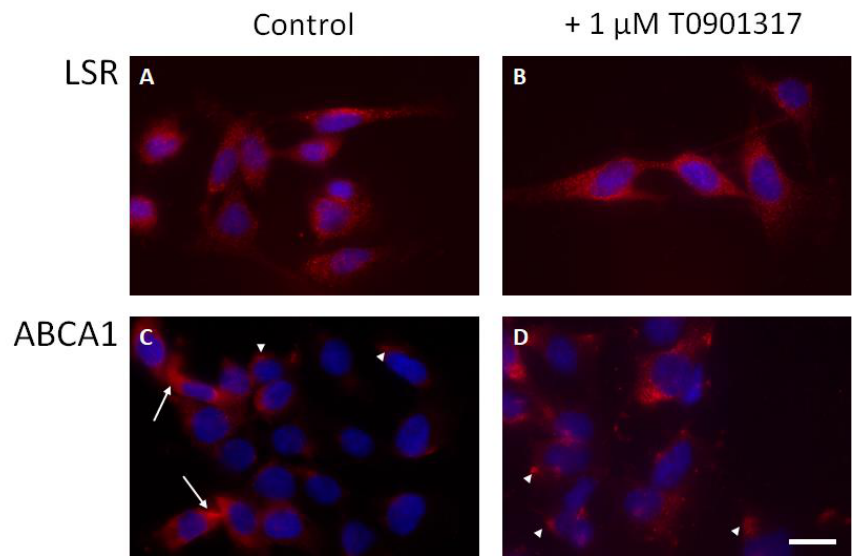
Figure 5. LSR and ABCA1 localization in astrocytes. LSR ( A , B ) and ABCA1 ( C , D ) protein levels were detected by immunofluorescence (red) in astrocytes grown in normal growth media (NM) in absence ( A , C ) or presence ( B , D ) of LXR agonist treatment (8 h, 1 µM T0901317). Co-labelling with DAPI to stain cell nuclei (blue) is shown in all panels (Scale bar = 10 µm). Arrows show strongly labelled cells; arrowheads show cells with discrete patchy or focal staining.